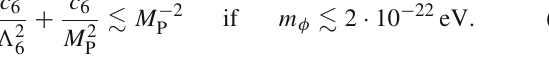
with ˜ c 3 ∼ O ( 1 ) , the bounds are much weaker 3 . Therefore,